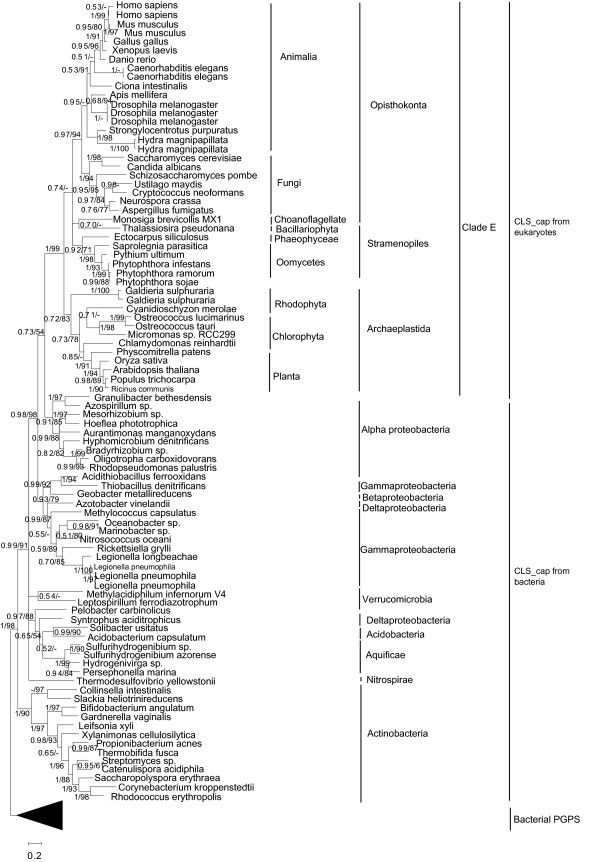
Phylogeny of all CLS_cap from eukaryotes and bacteria, and PGPS homologs of bacteria. Tree was inferred using MrBayes 3.12 on aligned amino acid dataset. Numbers at the nodes correspond to Bayesian posterior probabilites ≥ 0.50 (at the left of slashes) and the bootstrap value of ML tree (at the right of slashes). Scale bar indicates number of change per site. Bacterial PGPS are condensed as a triangle clade and rooted as outgroup.